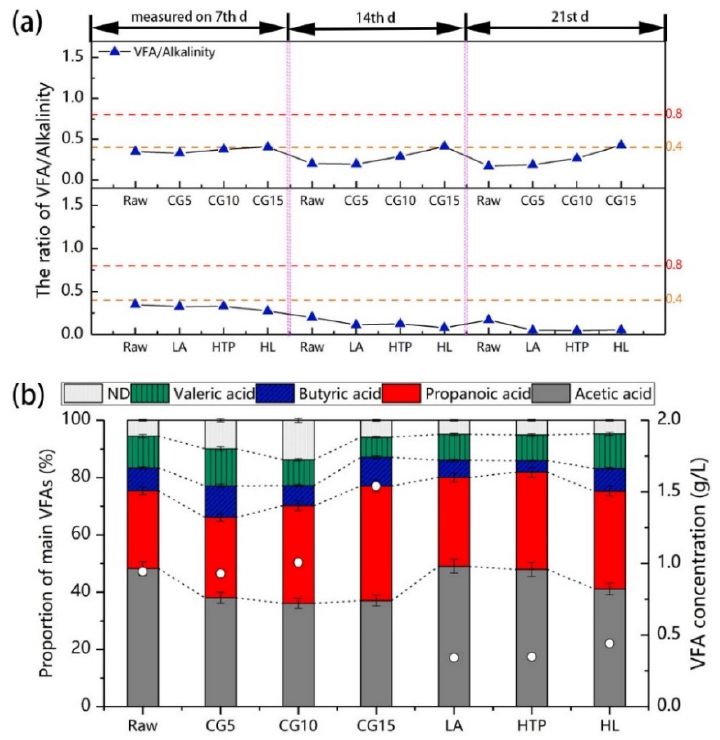
Figure 3. ( a ) VFA/alkalinity ratio; ( b ) main VFA compositions and proportions measured on the 21st